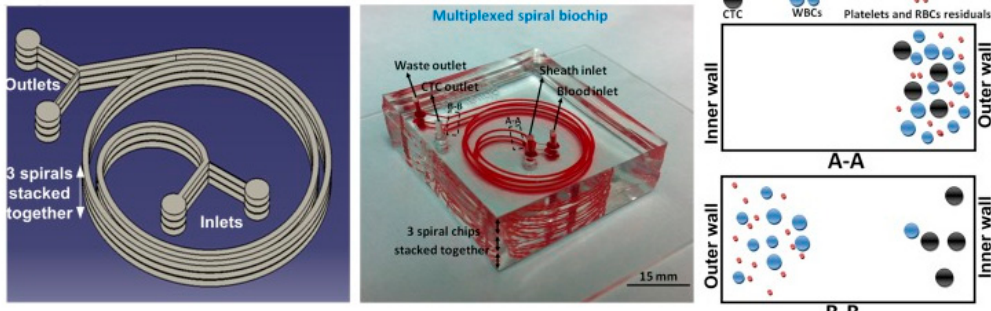
Figure 9. Illustration and photograph of the multiplexed spiral microdevice. (Reprinted from [63]).